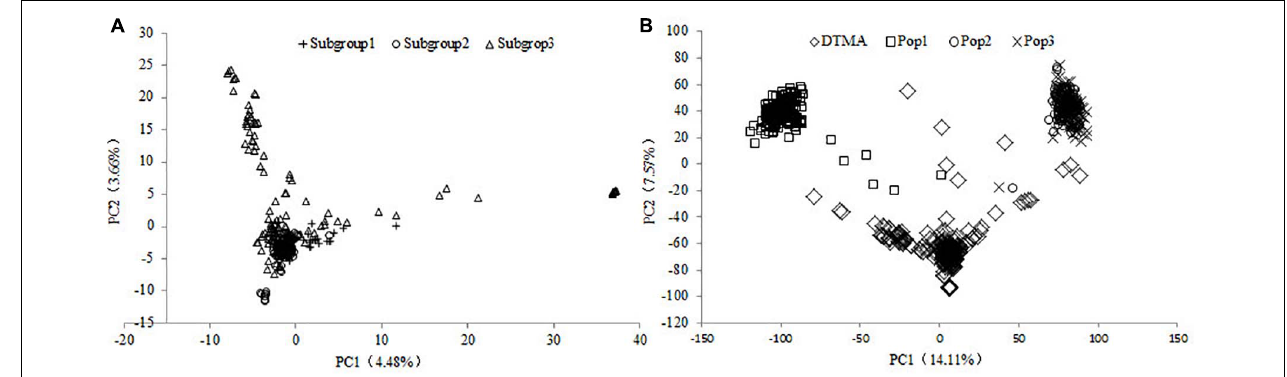
FIGURE 1 | Results of the principal components (PC) analysis in the (A) DTMA association mapping panel, and in (B) all the four populations of DTMA association mapping panel, Pop1, Pop2, and Pop3.